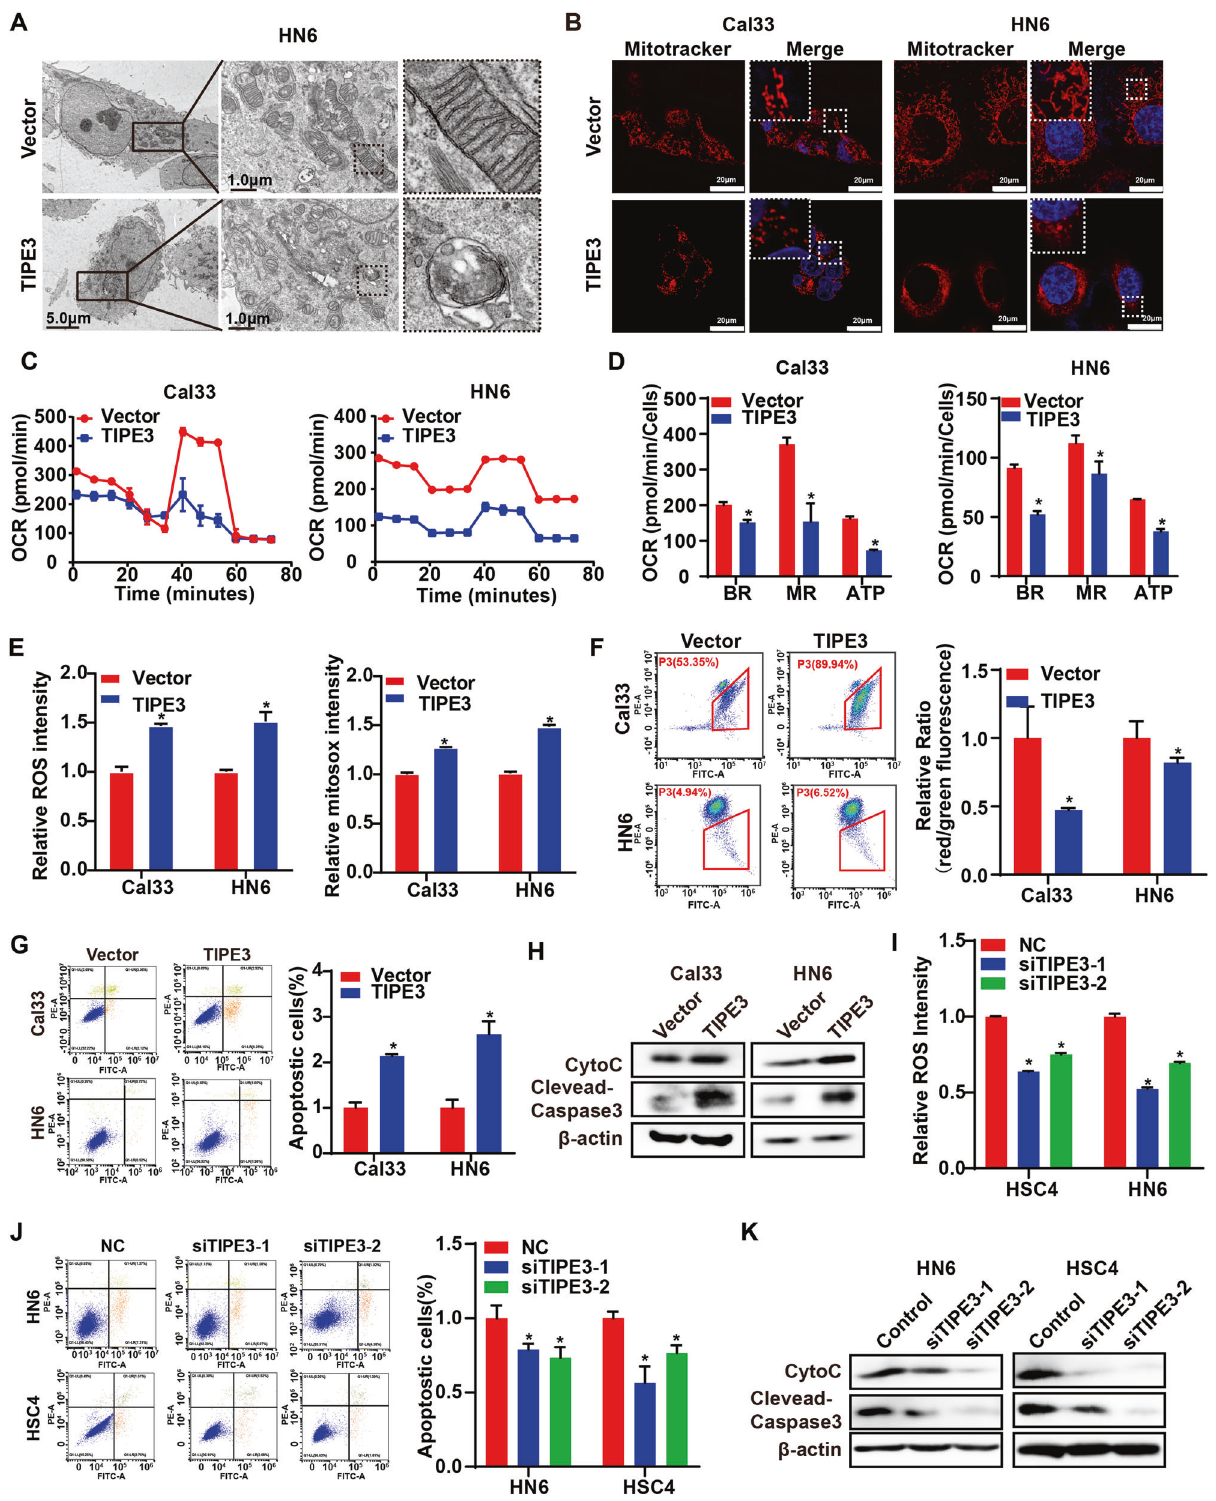
Fig. 4 TIPE3 triggers mitochondrial damage and dysfunction. The mitochondrial stresses induced by TIPE3 were evaluated in Cal33 cells with vector or TIPE3 overexpression. A Representative TEM imaging of mitochondria. B Representative fl uorescence imaging of mitochondria (red). C , D Oxygen consumption rate (OCR) of mitochondria ETC complex. E The cellular ROS and mtROS were determined with DCFH-DA and MitoSOX staining respectively. F The mitochondrial membrane potential was assessed by JC-1 staining. G Annexin-V-FITC/PI analysis of cell apoptosis. H WB analysis of cytoC, cleaved-caspase3, and β -actin expressions. I – K The si-NC or siTIPE3s transiently transferred into HN6 and HSC4 cells were used to examine the mitochondrial stresses suppressed by knocking down TIPE3 in HNSCC cells. I The cellular ROS was